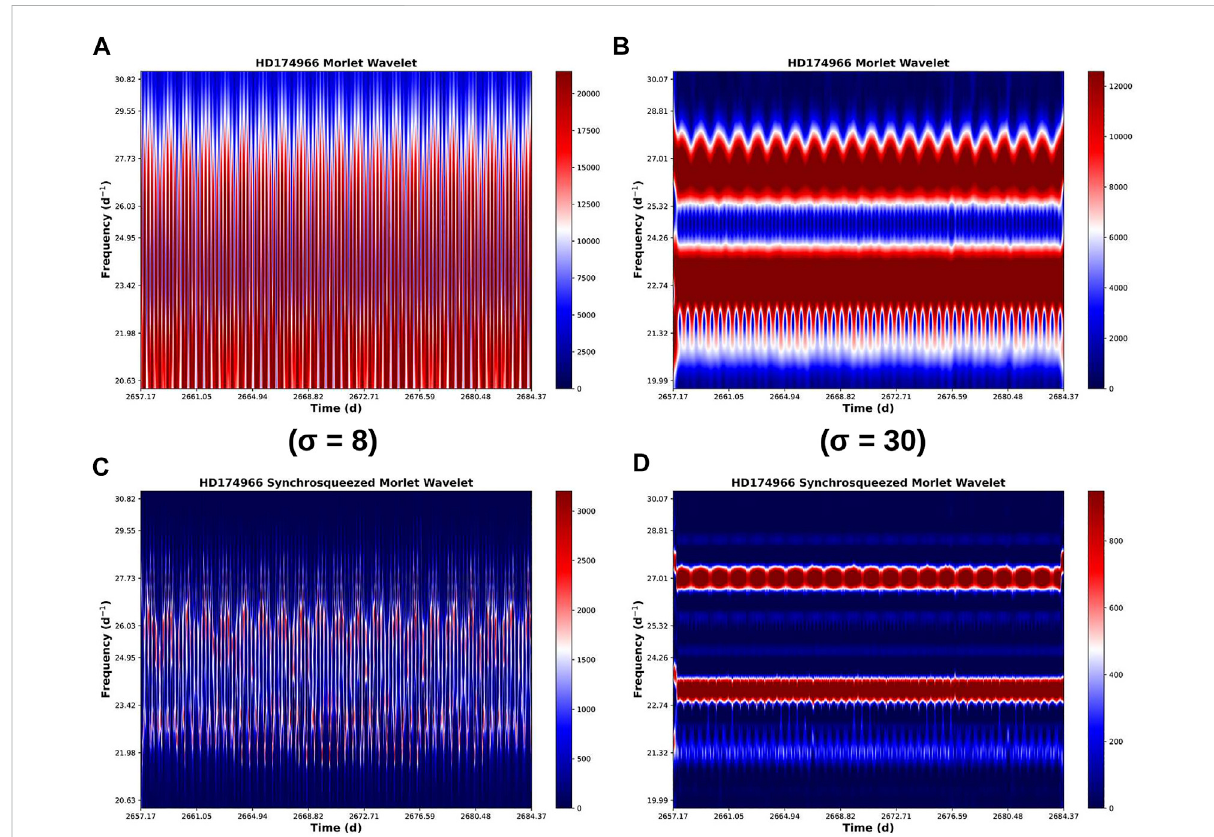
FIGURE 1 ExampleofaSSCWTanalysisofthesameregionofpulsationfrequenciesforHD174966.Theplotshowstheoscillationfrequenciesversustime. Thecolourmapshowsthepowerofthewaveletcoef fi cientsinarbitraryunits. (A) :InterferencepatternthatappearsintheCWTwhenthefrequencies are too close to resolve setting σ = 8 in the mother wavelet. The SSCWT in (C) is not able to resolve this frequencies either. (B) : the same set of frequencies are resolved by setting σ = 30. In this case, the three frequencies at 21.32, 23.24 and 27.01 d − 1 can be clearly seen. The frequency at 27.01 d − 1 shows a wobbling inthepower,probably because thefrequenciesofthedaughterwavelets that scanned that region didnot exactly match the frequency of the signal, thus generating the effect. The fact that this wobbling also appears in the analysis of the synthetic curve (not shown) is whatled us to think that thisvariation wasnot arealmodulation inamplitude.The lightbluebandsin (D) atabout24.2, 25.3 and 28.7 d − 1 are artefacts of the synchrosqueezing algorithm, created at the places where there were the edges of the frequency bands in the CWT (B)